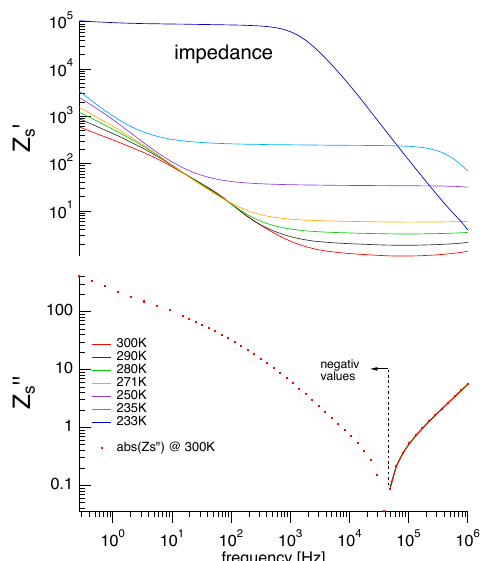
Figure 11. Impedances Z as measured on phosphoric acid (PA) with the setup for simultaneous n-DE-spectroscopy. Upper fig- ure: real part of the serial impedance Z (cid:48) . Lower part of the figure: s imaginary counterpart Z (cid:48)(cid:48) which changes sign at the frequency s indicated by a dashed vertical line (positive at high and negative at low frequencies). Dots in the lower figure correspond to the absolute value of Z (cid:48)(cid:48) shown for T = 300 K s